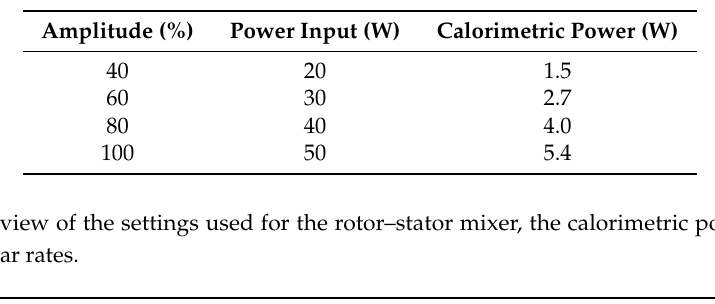
Table 2. Overview of the settings used for the ultrasound probe and the calorimetric powers.